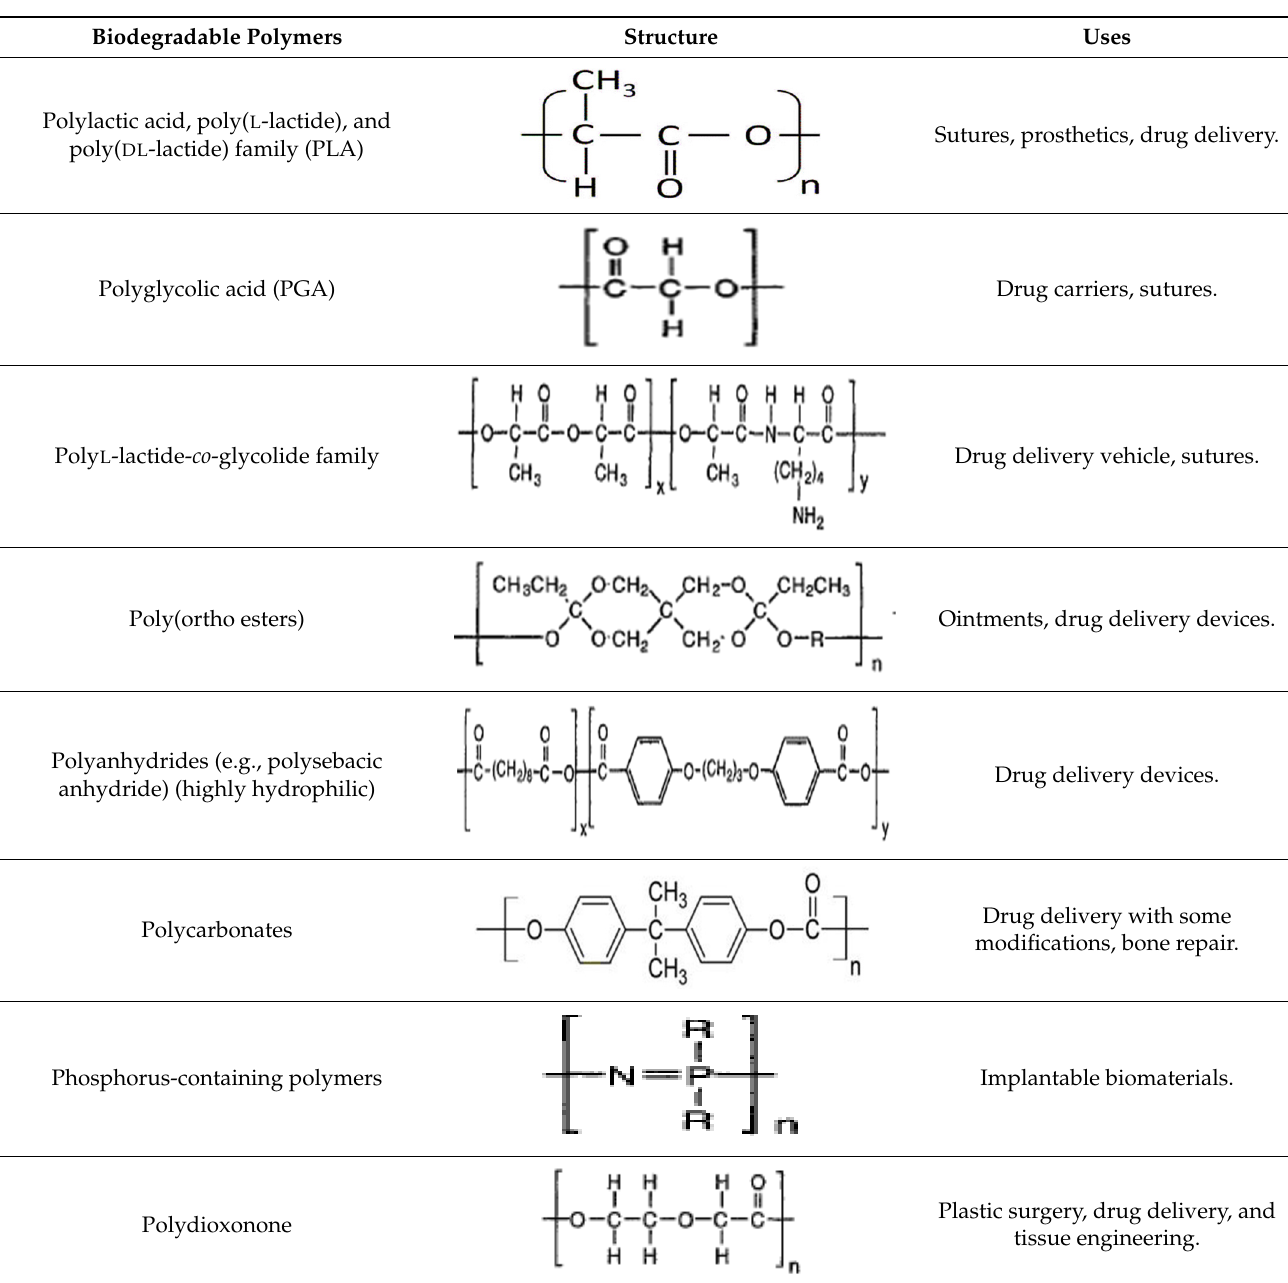
Table 1. Biodegradable polymers, with their structure and possible applications [110,112].